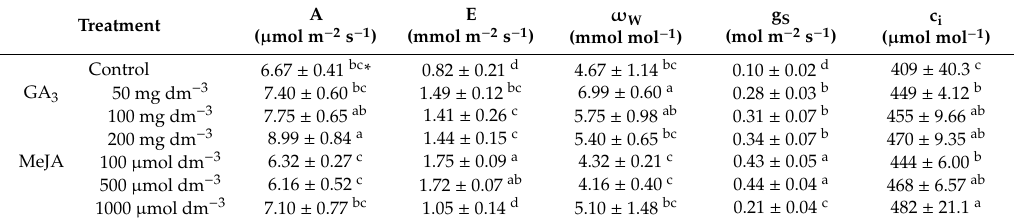
Table 4. E ff ects of GA 3 and MeJA on CO 2 assimilation intensity (A), transpiration (E), photosynthetic water-use e ffi ciency ( ω W ), stomatal conductance (g s ), and CO 2 concentration (c i ) of × A. tubergenii “Zwanenburg”.